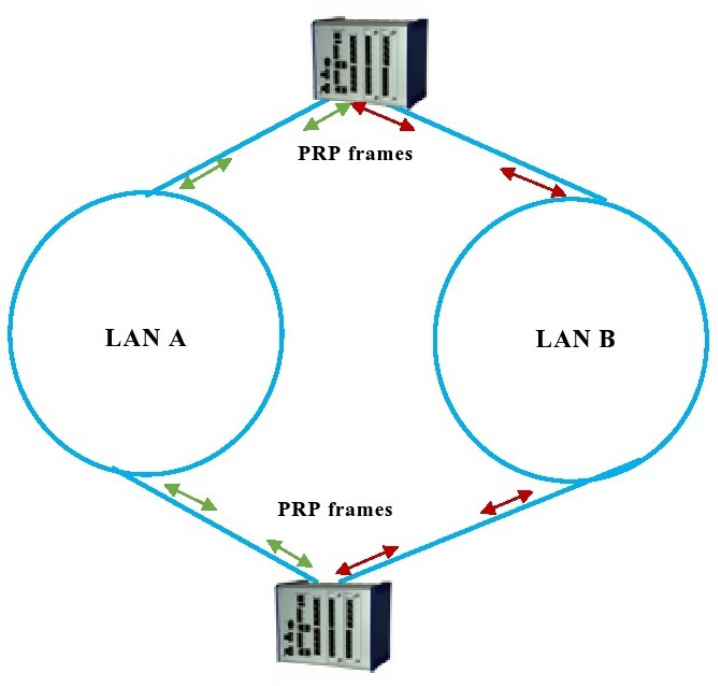
Figure 12. PRP network topology.